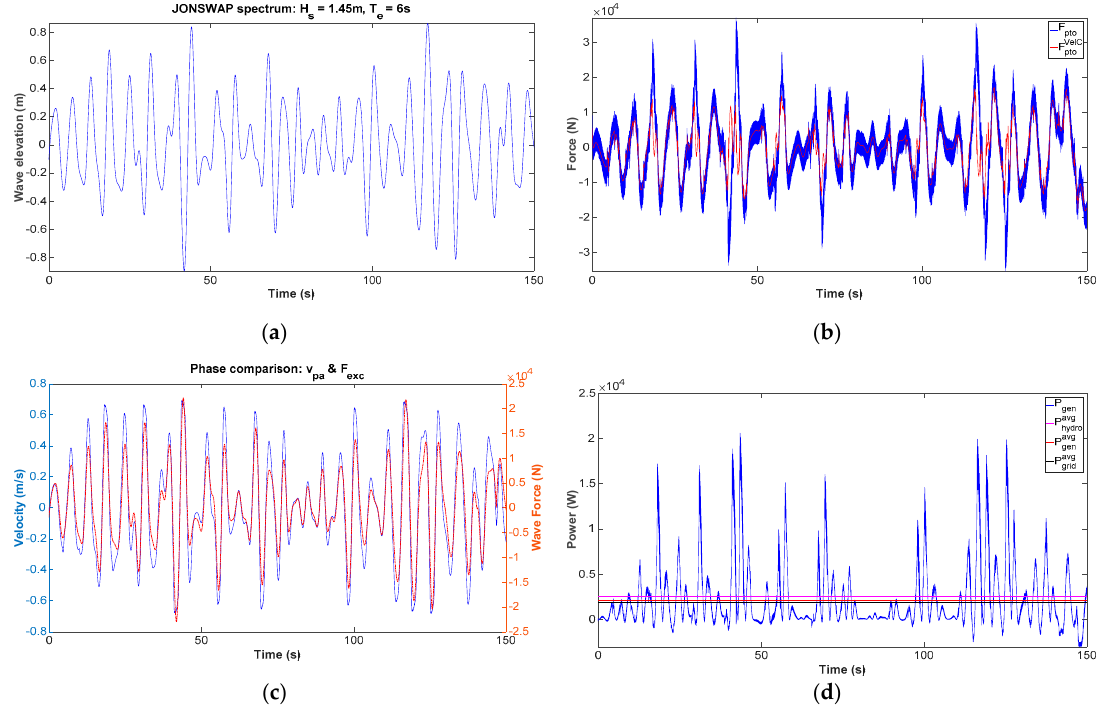
Figure 14. Simulation results using the v linear VelC. ( a ) Wave resource used as input; ( b ) Reference and